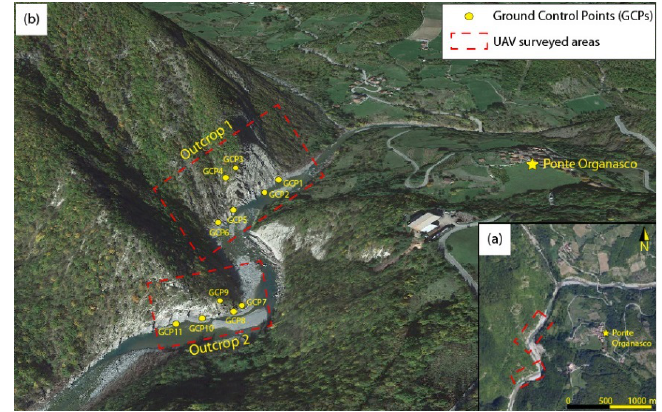
Figure 3. The study outcrops marked on ( a ) an orthorectified aerial image and ( b ) a perspective image. In ( b ) the positions of the Ground Control Points (GCPs) are shown. In ( b ) the positions of the Ground Control Points (GCPs) are